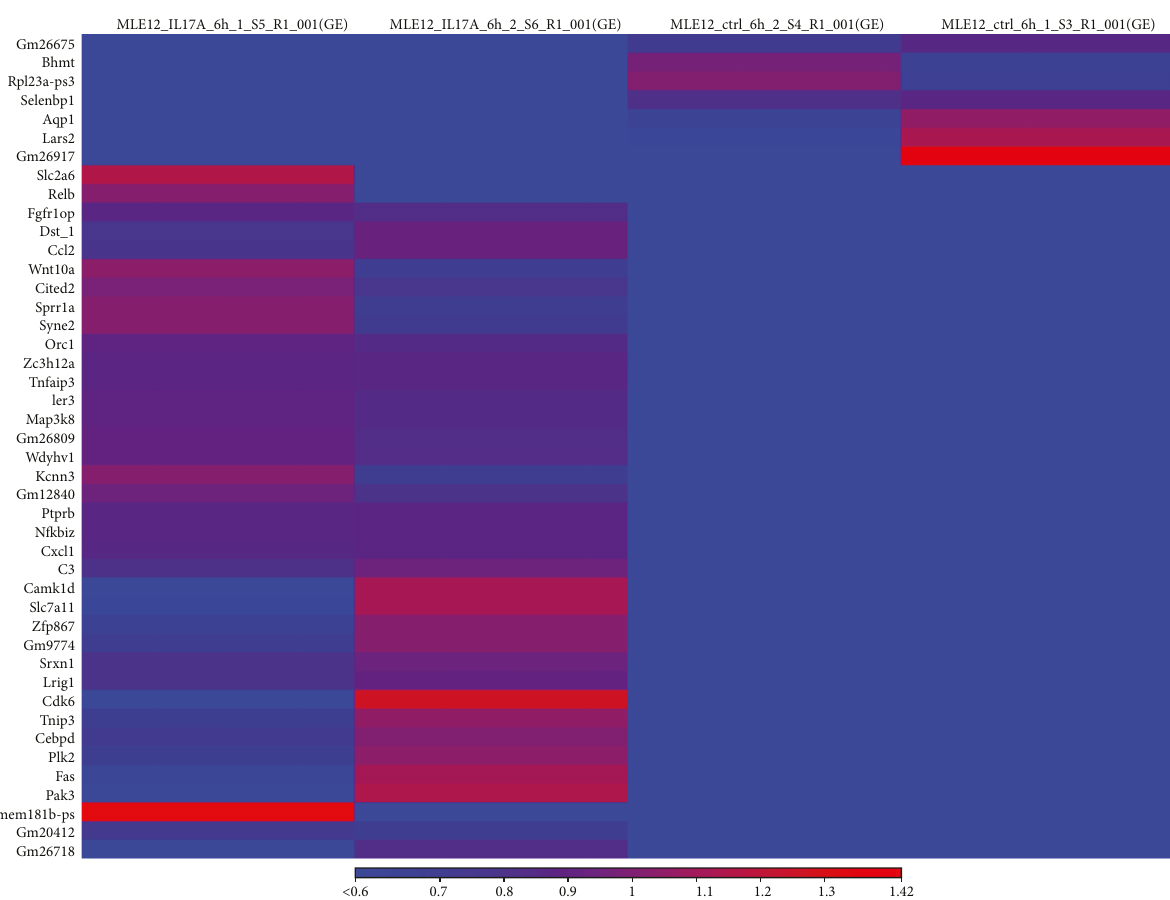
Figure 8: Heat map of genes regulated by IL-17A (50 ng/ml for 6h) in MLE12 cells. The left two columns shown on the map were the two samples of m-IL-17A-treated group, and the right two columns were the control group